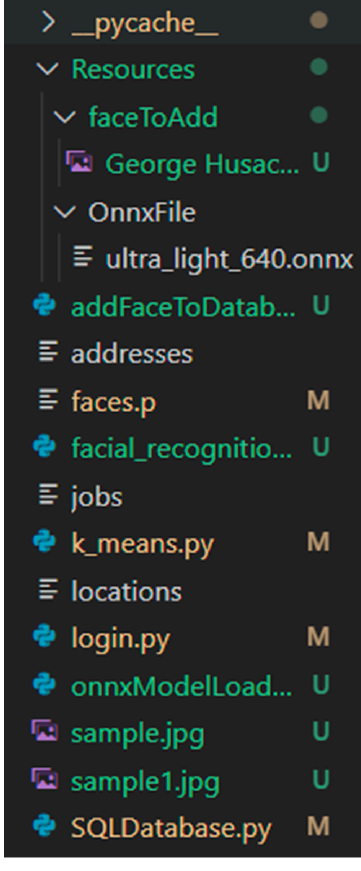
Figure 7. An overview of application files.